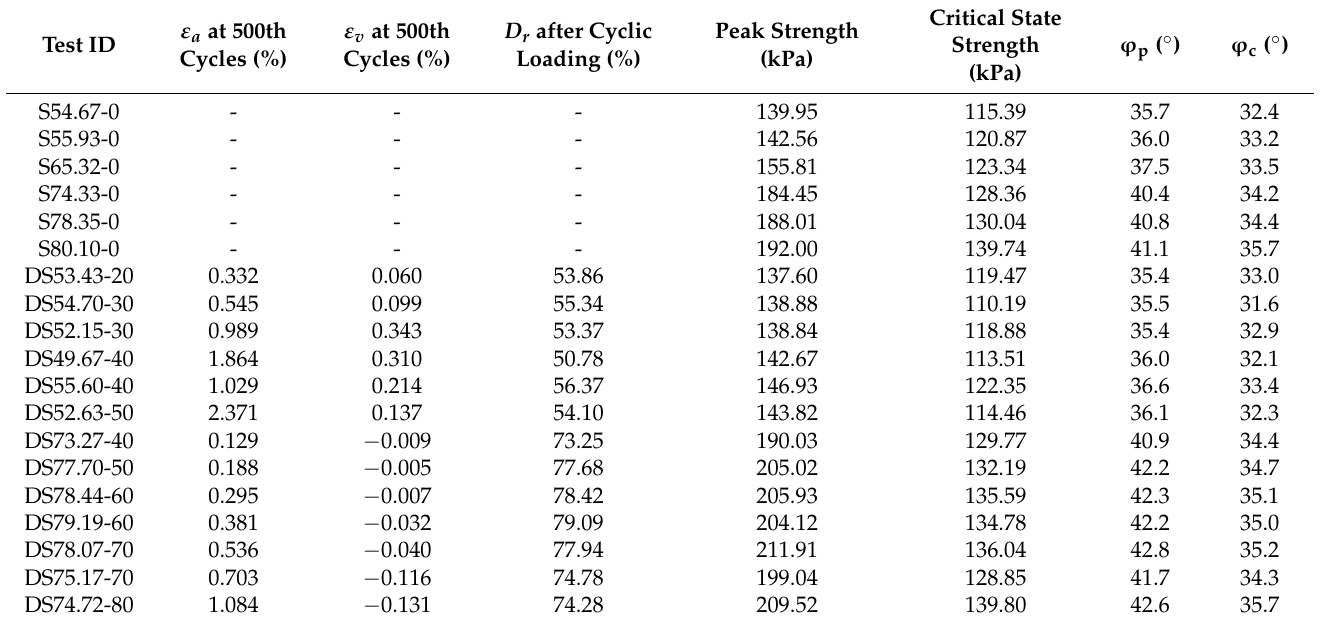
Table 2. Results of drained cyclic and monotonic shear test.